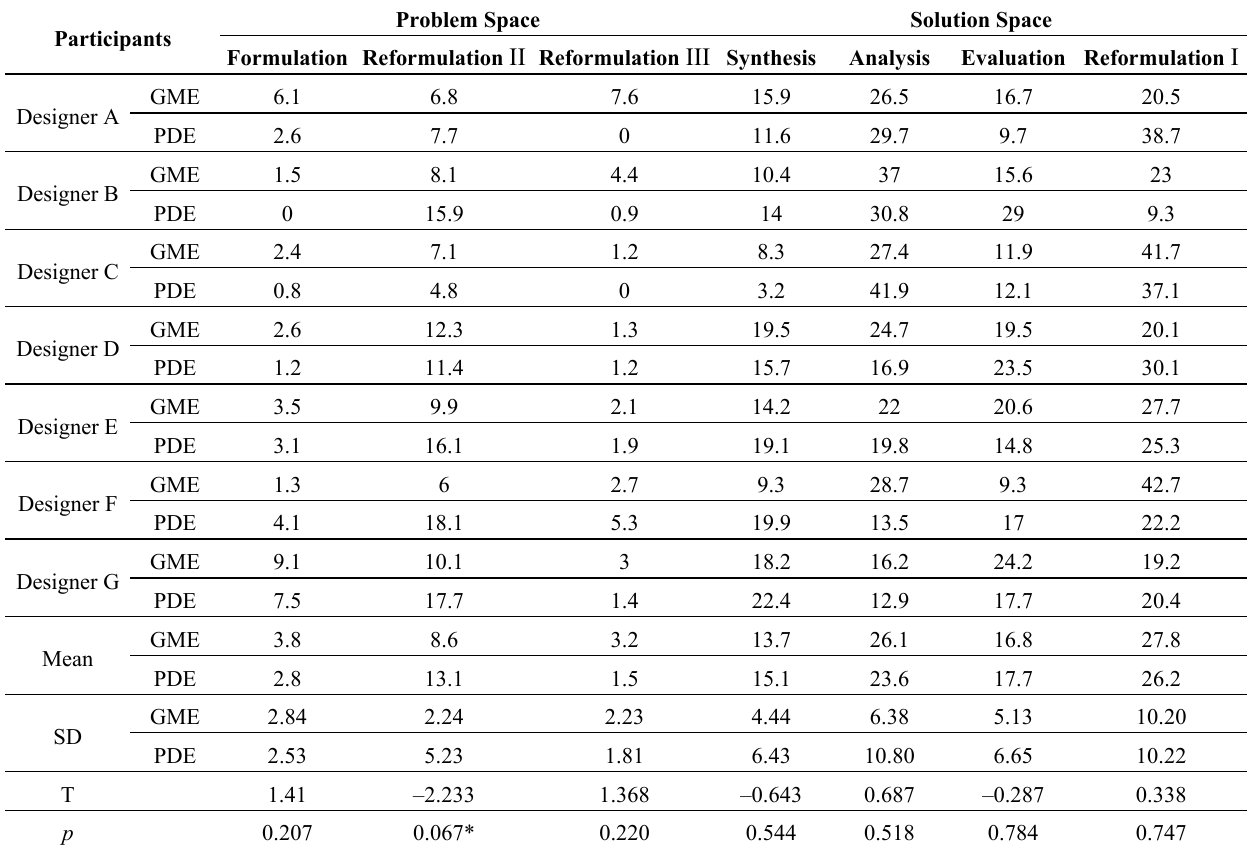
Table 4. Syntactic design processes distributions in the GME and PDE.